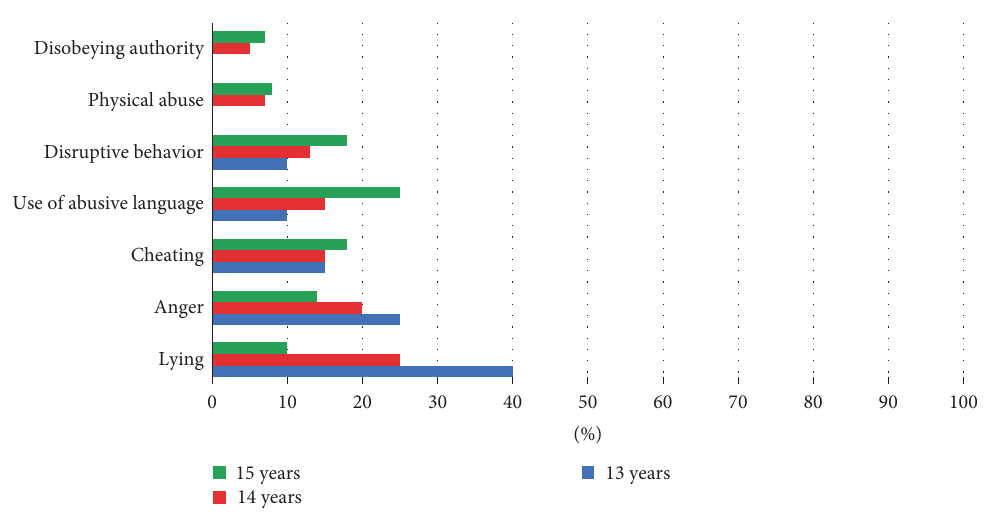
F IGURE 2: The percentage of the degree of social behavior.